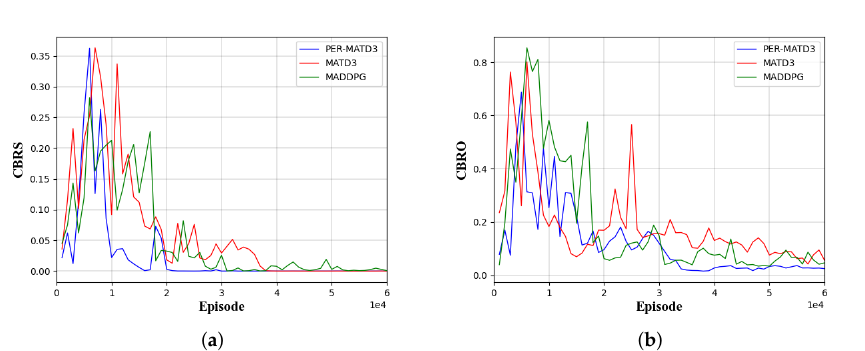
Figure 7. Collision rate during robot formation movement: ( a ) collision rate between robots (CBRS); ( b ) collision rate between robots and obstacles